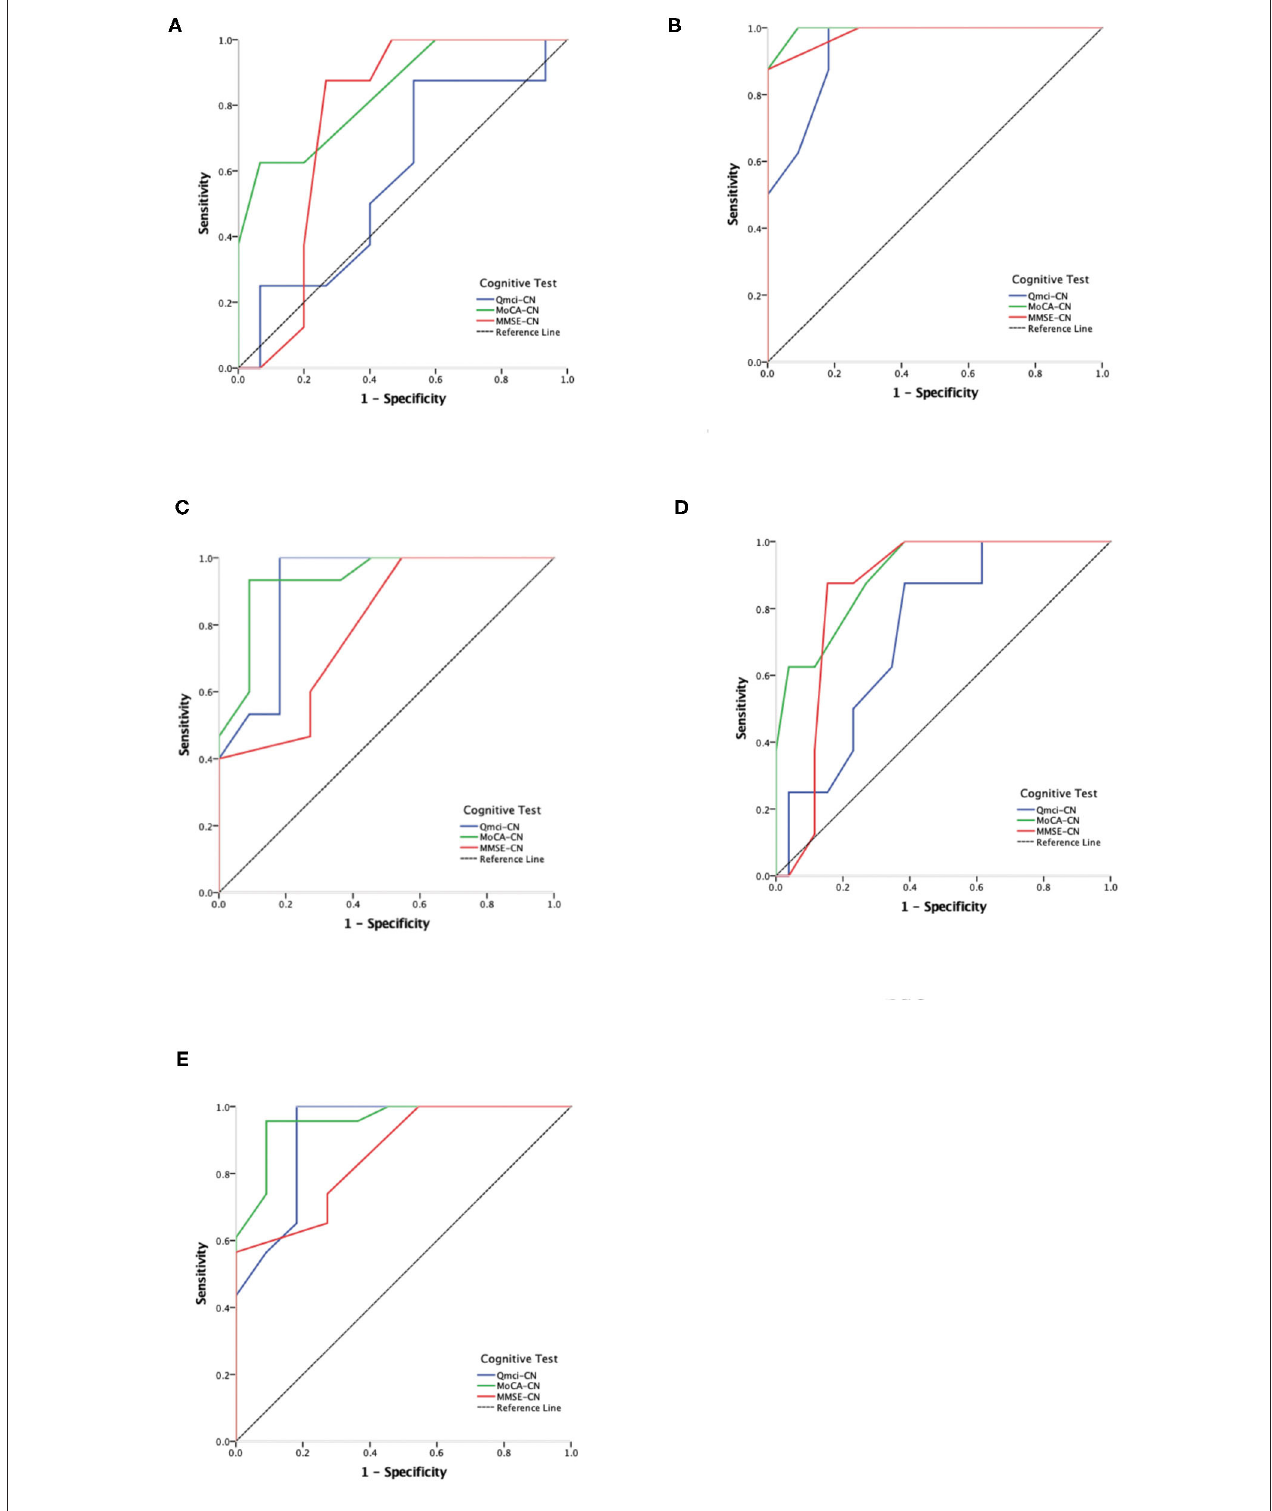
FIGURE 1 | Receiver Operating Characteristic (ROC) curve analysis comparing the Chinese versions of the Quick Mild Cognitive Impairment (Q mci -CN) screen, Montreal Cognitive Assessment (MoCA-CN) and Mini Mental State Examination (MMSE-CN) in separating normal cognition (NC), post-stroke cognitive impairment no dementia (PSCIND) and post-stroke dementia (PSD). (A) NC vs. PSCIND; (B) NC vs. PSD; (C) PSCIND vs. PSD; (D) NC vs. PSCIND/PSD; (E) PSD vs. NC/PSCIND.